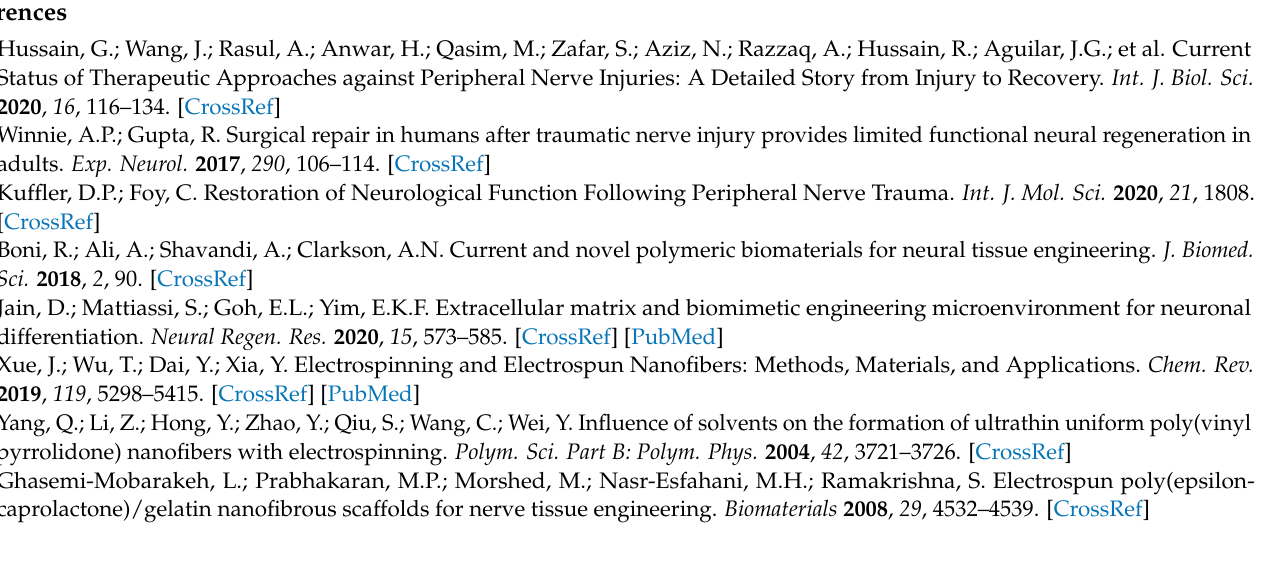
bar—20 µ m. Figure S5: Representative photomicrographs demonstrating the differences in the size of FAs formed by neurons when cultured on different types of substrates. Figure S6: Formation of neurospheres on oriented ultrathin